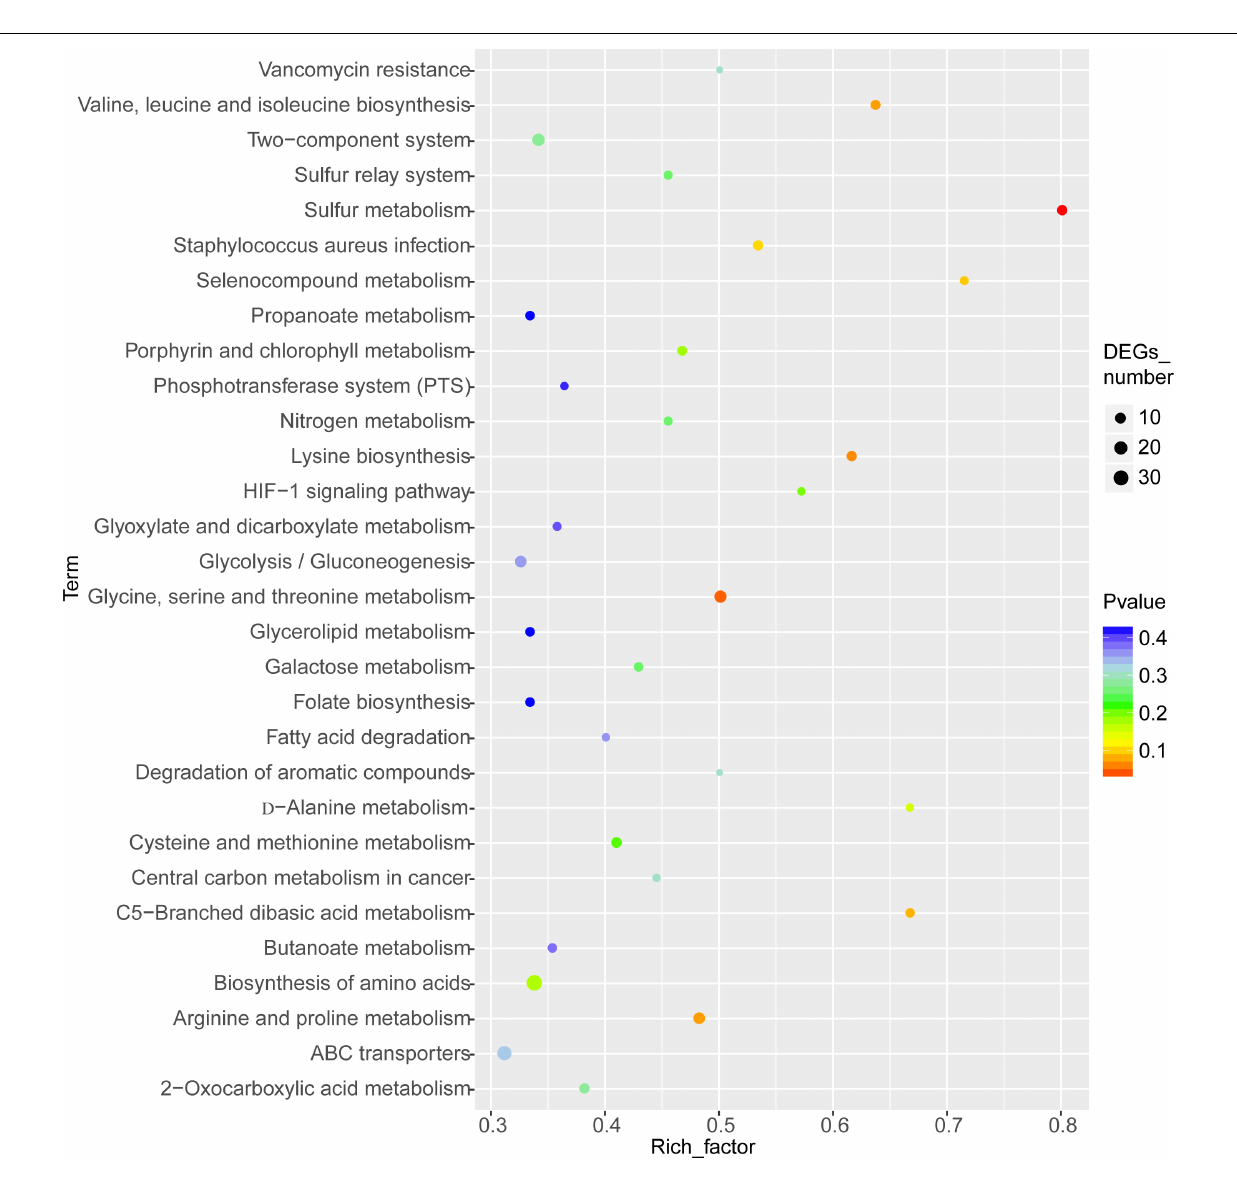
FIGURE 9 | Kyoto Encyclopedia of Genes and Genomes enrichment analysis of the differentially expressed genes (DEGs). The horizontal axis represents the enrichment factor [enriched to a Gene Ontology (GO) term]. The number of DEGs accounts for the ratio of the number of background genes obtained by sequencing. The ordinate indicates the GO term enriched features. The larger the circle, the greater the number of DEGs enriched in this